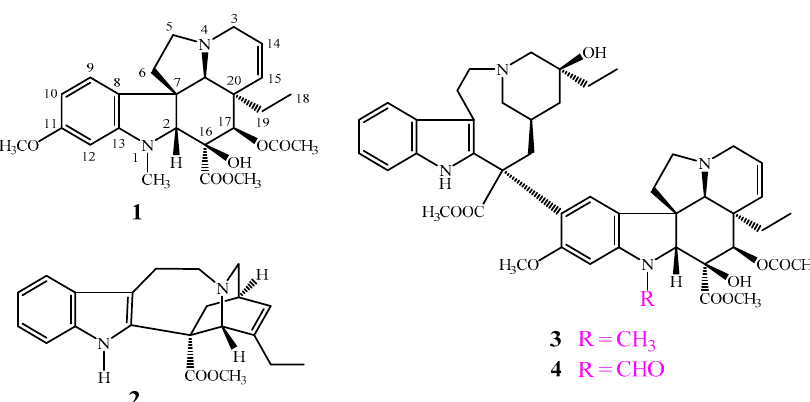
Figure 1. Vindoline ( 1 ), catharanthine ( 2 ), vinblastine ( 3 ), and vincristine ( 4 ) as representatives of the well-known Vinca alkaloid family.